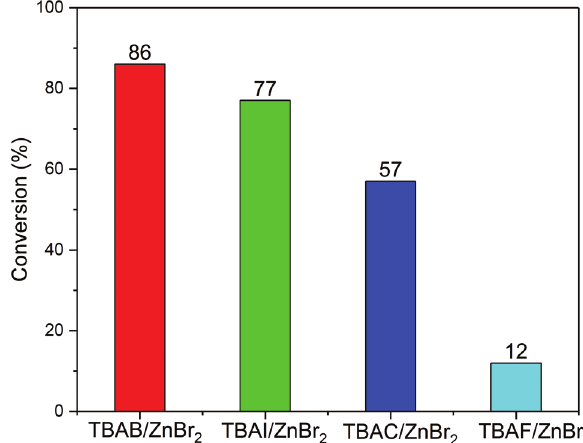
Figure 6: Catalytic activity of tetrabutylammonium halides (TBAX) in combination with ZnBr (reaction conditions: Solvent-free SO 2